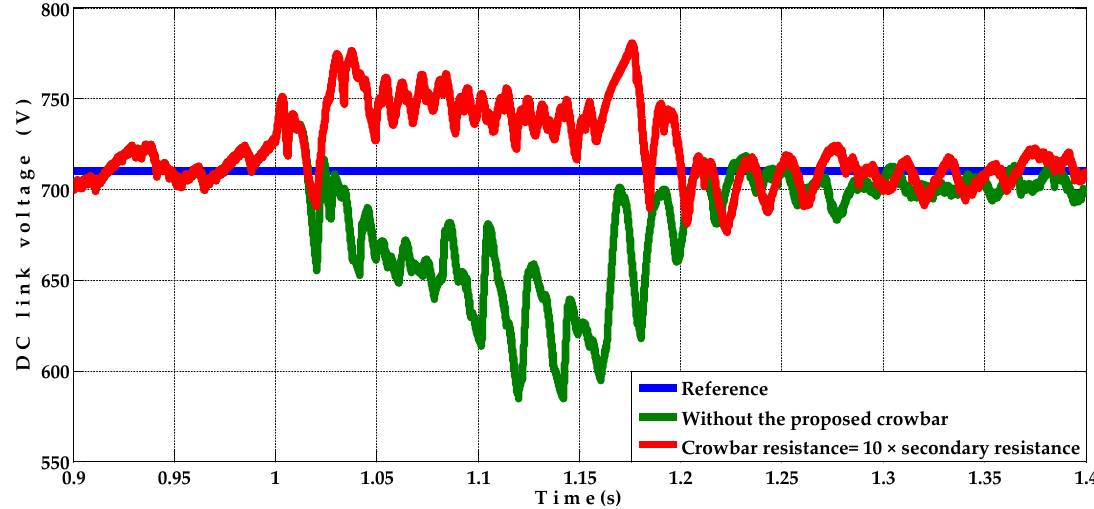
Figure 28. DC link voltage of BDFRG with and without the proposed crowbar under line-to-line fault occurrence.